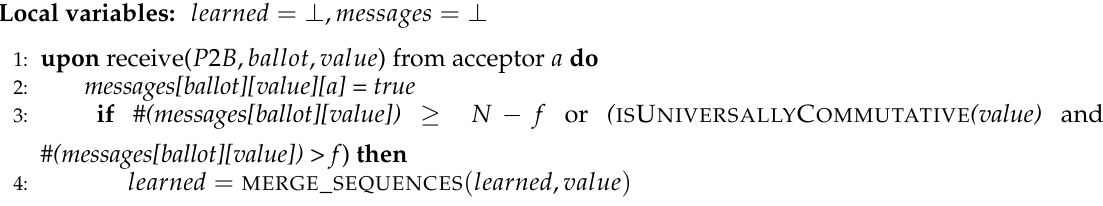
Algorithm 5 Generalized Paxos—Learner